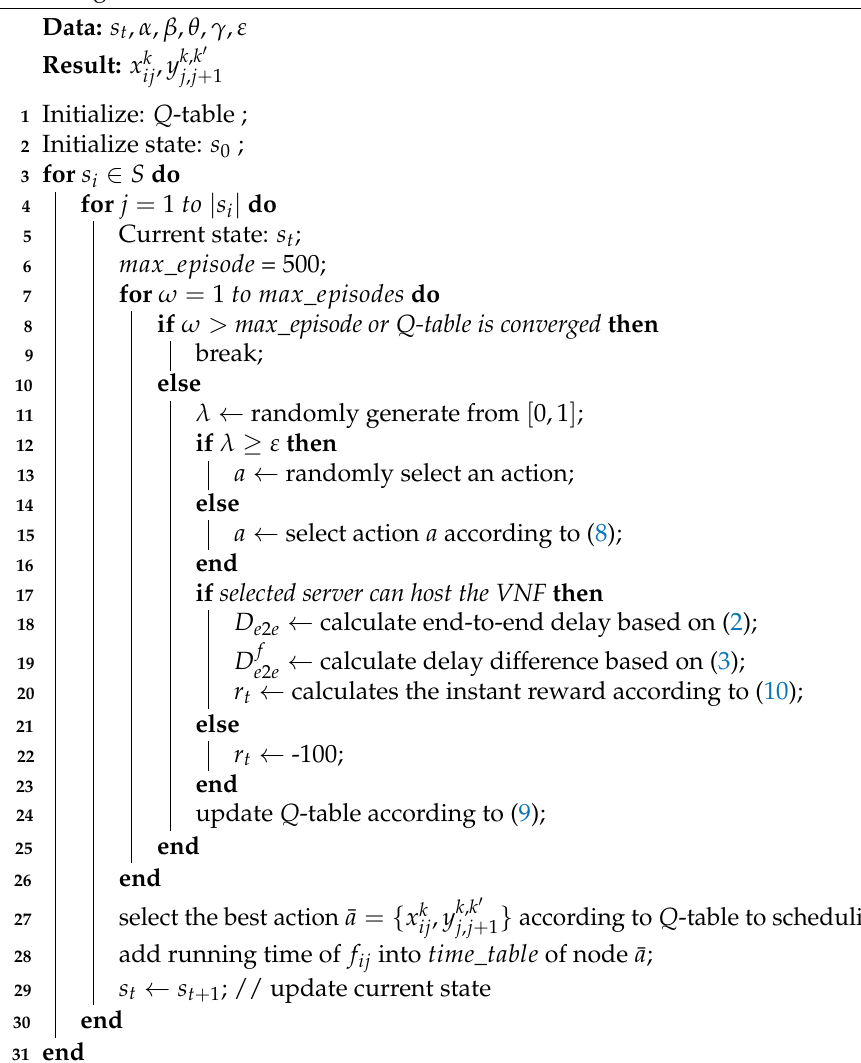
Algorithm 1: Delay-aware traffic scheduling algorithm based on reinforcement